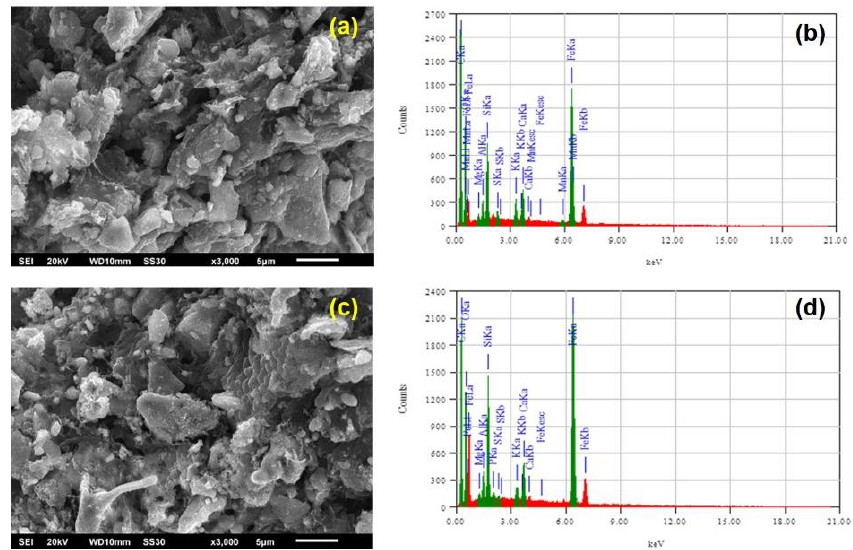
Figure 9. SEM images showing a change of iron ore surface after reduction and result of EDS analysis: ( a , b ) at 600 °C; ( c , d ) at 900 °C with heating rate 10 °C/min and reduction time 60 min.